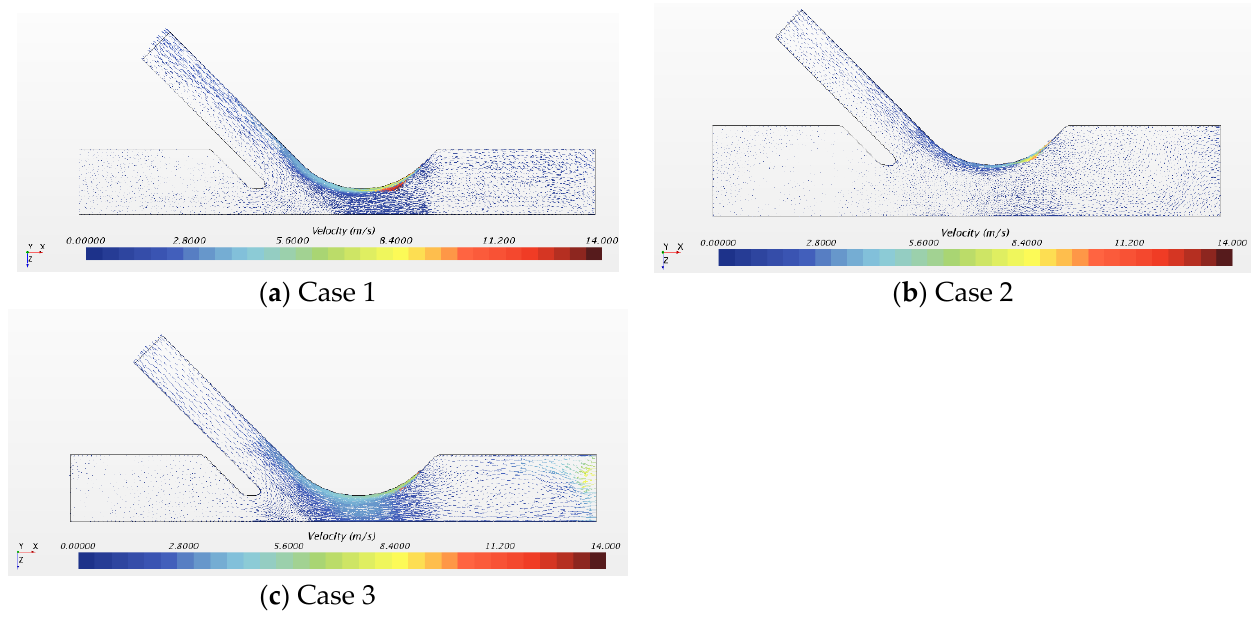
Figure 17. Velocity distribution in the central x-z plane of the Coandă-based collector model.